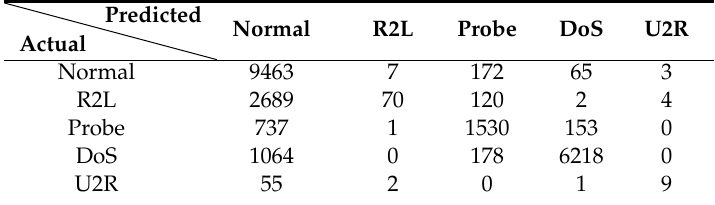
Table 4. Confusion matrix for non-modified NSL-KDD Test +